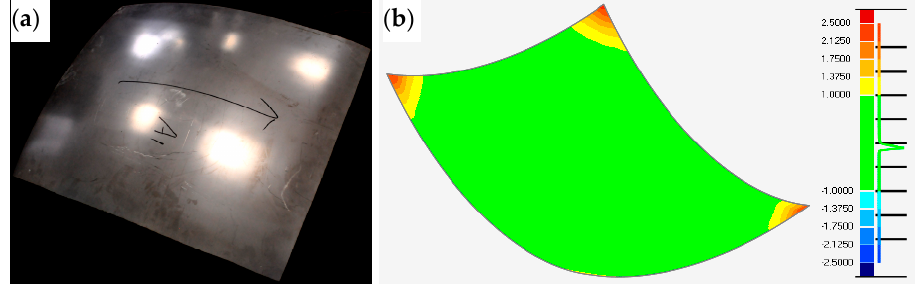
Figure 15. Spherical part in the experiment. ( a ) Spherical part; ( b ) shape error distribution in a normal direction.